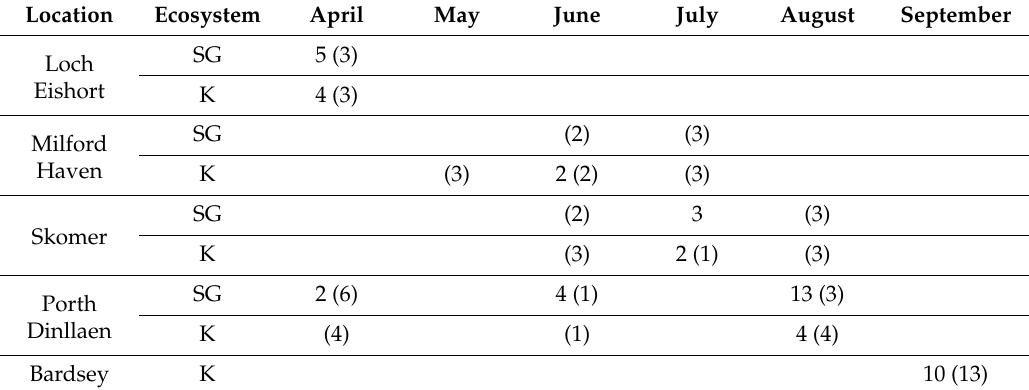
Table A1. Successful deployments in seagrass (SG) and kelp (K) ecosystems at the five study sites between April and October 2017. Brackets indicate failed deployments. Total of 116, of which 49 were